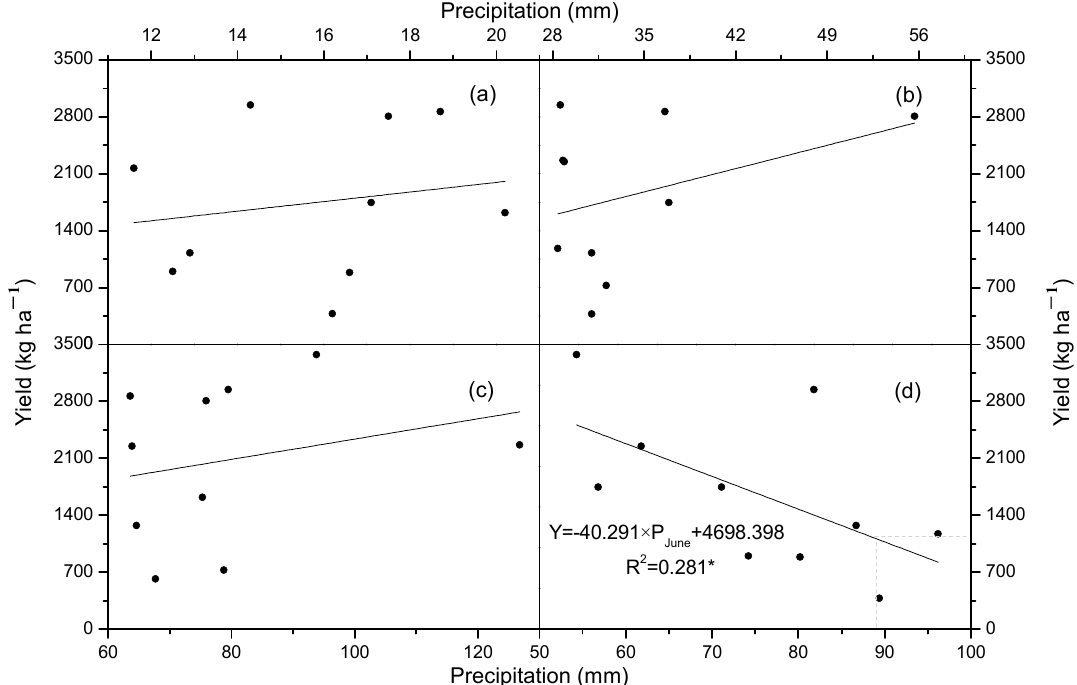
Figure 2. Responses of spring wheat yield to the ten greatest records of precipitation from March to June. ( a ) March, ( b ) April, ( c ) May, ( d ) June. * indicates signi fi cant level at 0.05.